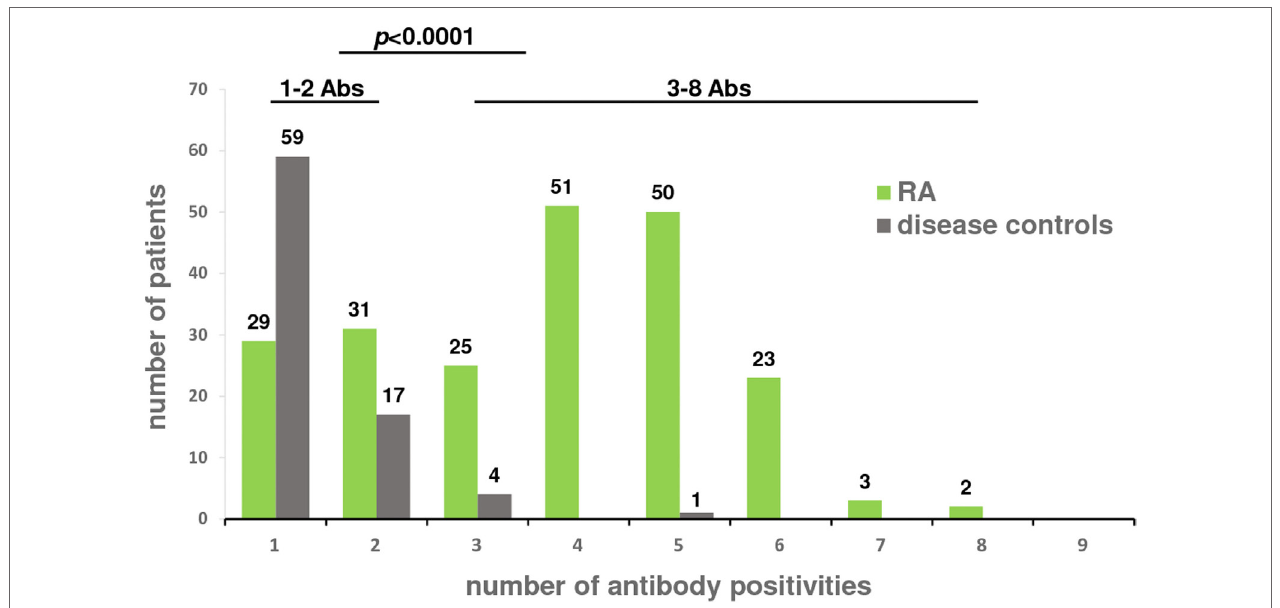
FigUre 4 | Number of antibody positivities in rheumatoid arthritis (RA) patients and disease controls. 290 RA patients and 261 disease controls were tested for the presence of IgA, IgG, and IgM isotypes of rheumatoid factor, anti-citrullinated protein antibodies and RA33. The number of antibodies detected in a patient’s serum is indicated on the x -axis; the number of patients is indicated on the y -axis. Disease controls were found to have significantly ( p < 0.001) fewer antibody positivities (1–2 Abs) compared to RA patients who commonly had more than two antibodies (3–8 Abs).